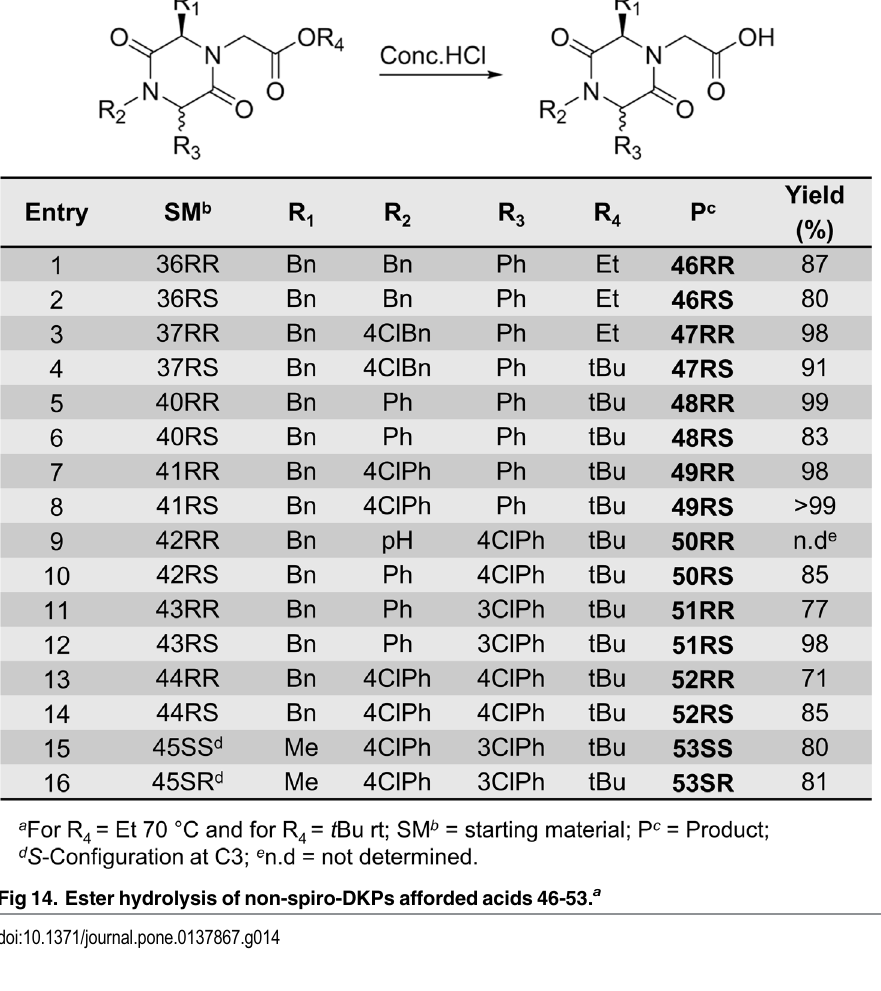
doi:10.1371/journal.pone.0137867.g014